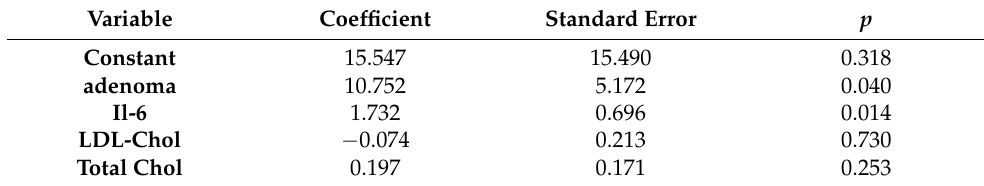
Table 6. Epithelial Immunofluorescence Intensity score (IFIS) for MAP-LC3 in the right colonic mucosa according to the presence of at least one colorectal adenoma at colonoscopy (adenoma), serum interleukin-6 levels (IL-6), serum low-density lipoprotein cholesterol levels (LDL-Chol), and serum total cholesterol levels (Total